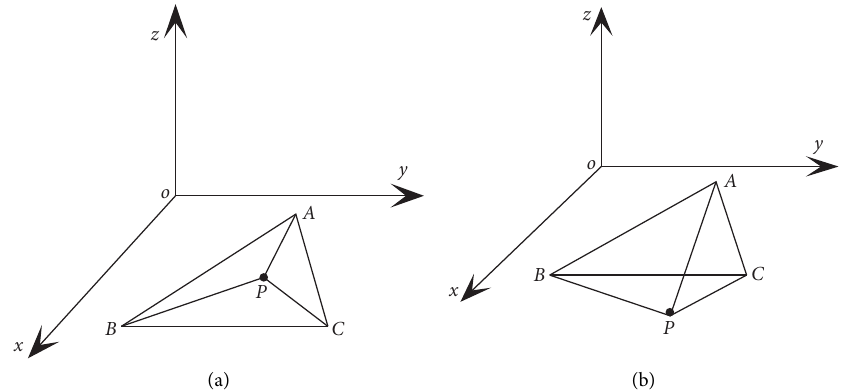
Figure 9: Te intersection point P is placed inside and outside of the projection ABC of the triangular plane element: (a) scenario 1 and (b) scenario